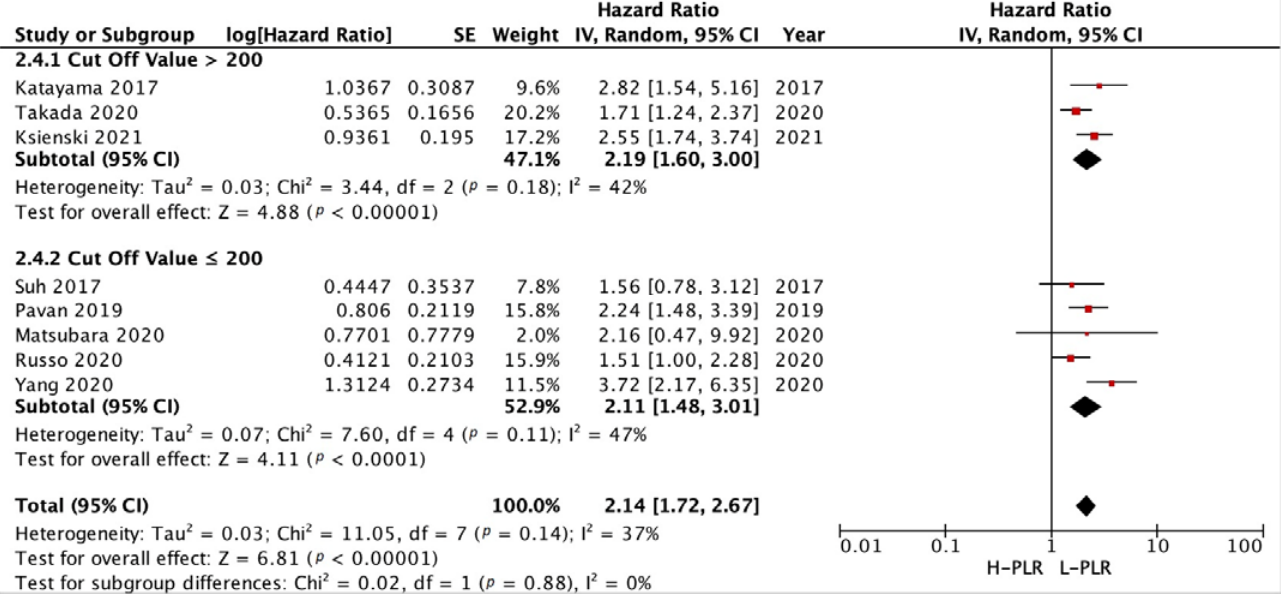
Figure 11. Forest plot cut-off value subgroup analysis of H-PLR versus L-PLR to OS in patients treated with immunotherapy. Red dots represent study weights; the bivalve represent the overall effect.